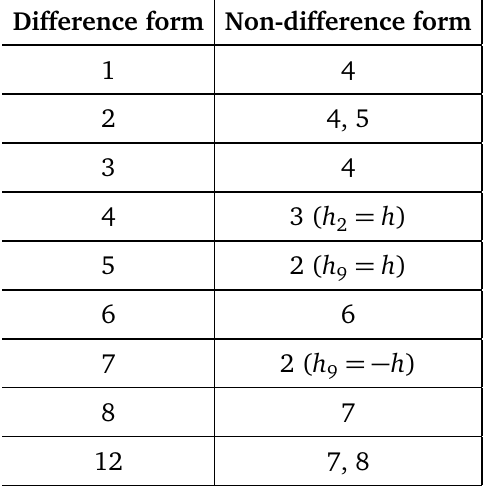
Table 7: Correspondence between difference form models in Table 1 of [ 40 ] and non-difference form of Table